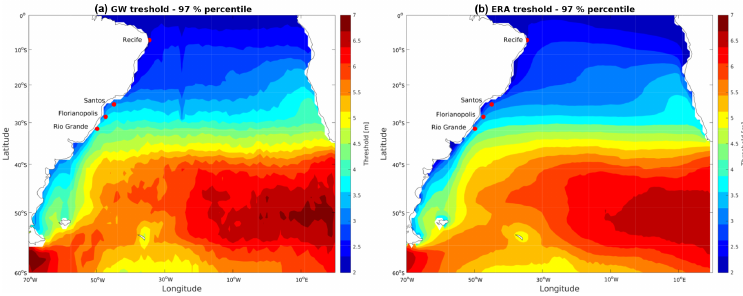
Figure 6. Spatial pattern of SWH threshold (97%) values from interpolated LOS data (a) and from ERA-Interim (b) in the South Atlantic.